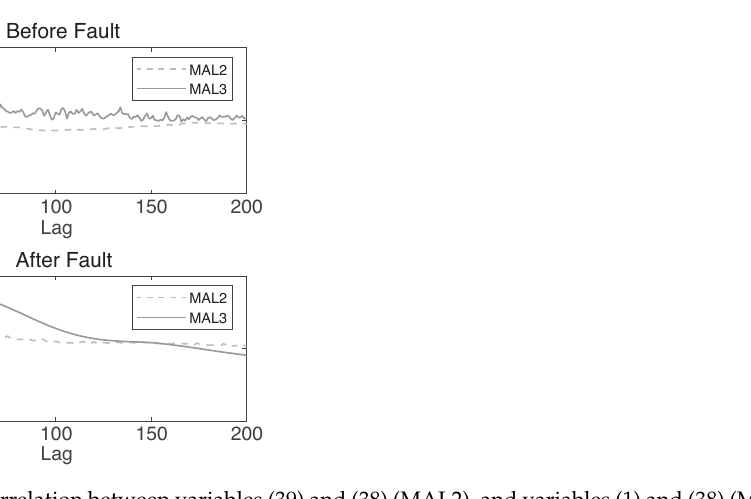
Figure 6. Cross-correlation between variables (39) and (38) (MAL2), and variables (1) and (38) (MAL3) before (top) and shortly after (bottom) fault